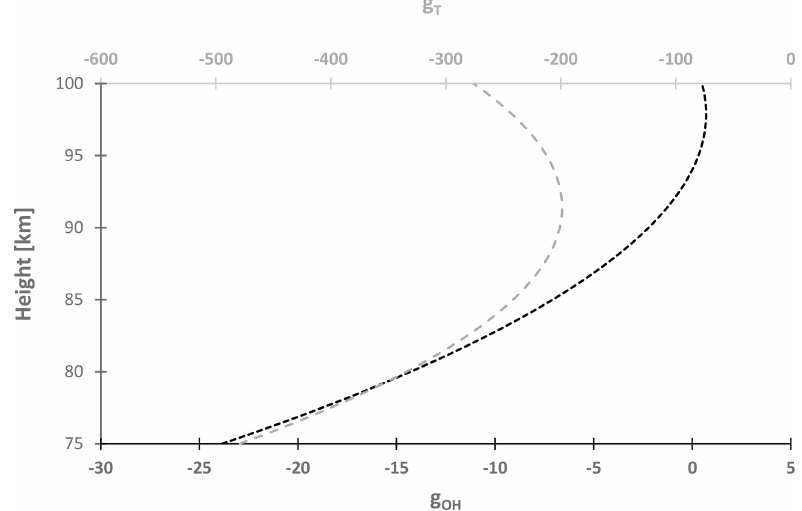
Figure 2. Height-dependent development of g T (grey) and g OH (black) according to the formulas (42) and (29) of Swenson and Gard- ner (1998) calculated for January: while g OH decays nearly linearly to zero, this is not the case for g T . Among other arithmetic operations, these factors are multiplied by the relative density perturbation and the undisturbed VER in order to derive the rotational temperature and the relative intensity perturbation. So, it becomes clear that relative intensity perturbations suffer less from averaging effects than the rotational temperature